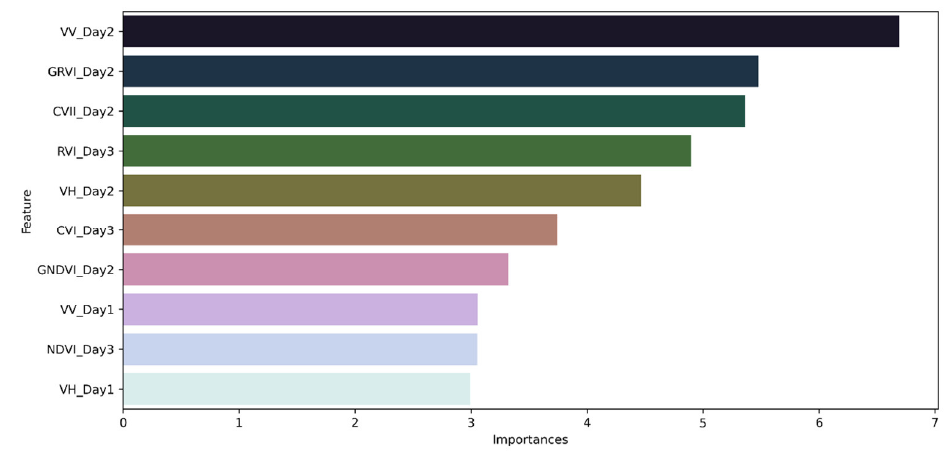
Figure 8. The 10 variables from S1 and S2 that most contributed to the model.